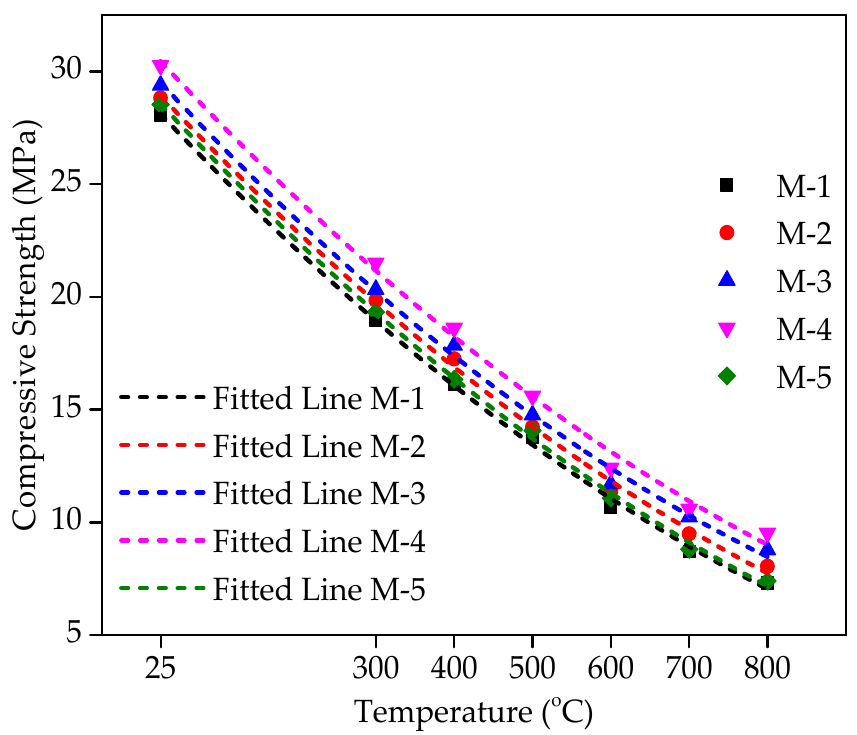
Figure 14. Relationship between the compressive under different temperatures and WFS content. As the value of R 2 exceeds 0.94, a polynomial association in different forms seems to be the best data connection with the various values of temperature and WFS contents. A coefficient of determination of R 2 = 0.99 shows a strong data connection. A higher coefficient of determination value shows that compressive strength has a strong connection with various WFS content and temperature levels. Equations for each level of replacement and temperature are given below in Equations (1)–(5).